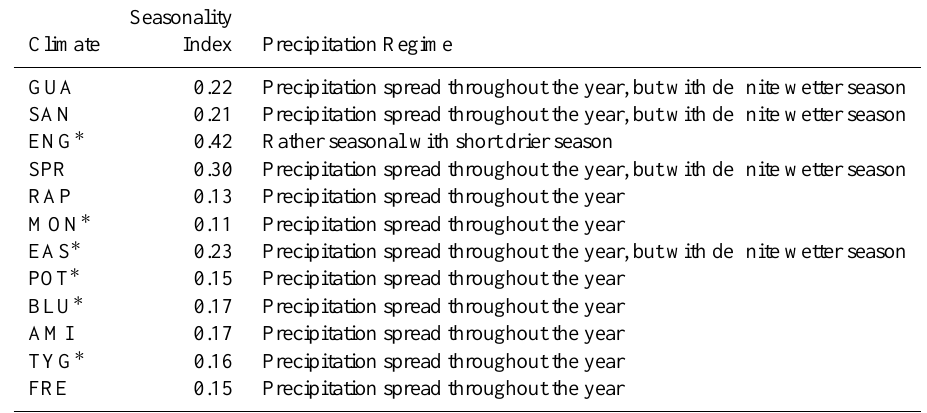
Table 1. Seasonality index for the 12 MOPEX catchments ( ∗ indicates catchment with some snow).